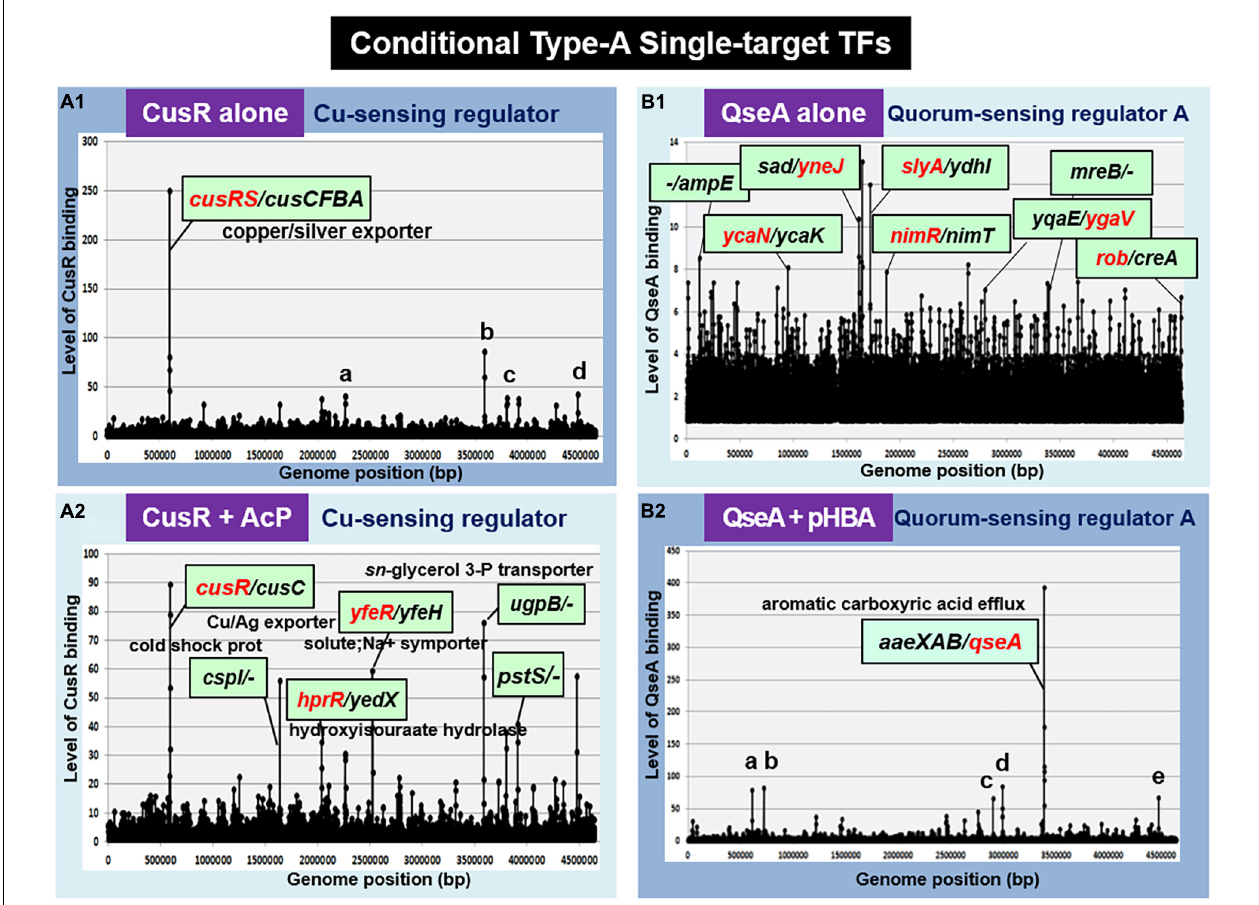
FIGURE 3 | gSELEX patterns of the conditional type-A ST-TFs. (A1) CusR alone. One high-level peak of ST-TF was identified inside the spacer between the cusRS and cuscFBA operons. Four minor and supposedly non-specific binding peaks represent: a. ORF( fruB ); b. spacer ( ugpB/- ); c. ORF ( rfaS ); and d. ORF ( yjgN ). (A2) CusR + AcP. Nine high-level peaks were identified, including the cusR/cusC spacer. (B1) QseA alone. In the absence of effector, QseA binds more than 50 sites. It remains unsolved whether these bindings represent certain physiological roles. (B2) QseA + pHBA. One high-level peak of ST-TF was identified. In the presence of an effector ligand pHBA, QseA recognizes and binds to a single target within the spacer between aaeXAB and qseA. Five minor and supposedly non-specific peaks represent: a. ORF ( entD ): b. spacer (-/-): c. spacer (-/-): d. spacer (-/ ygeG ): and e. ORF ( yjgL